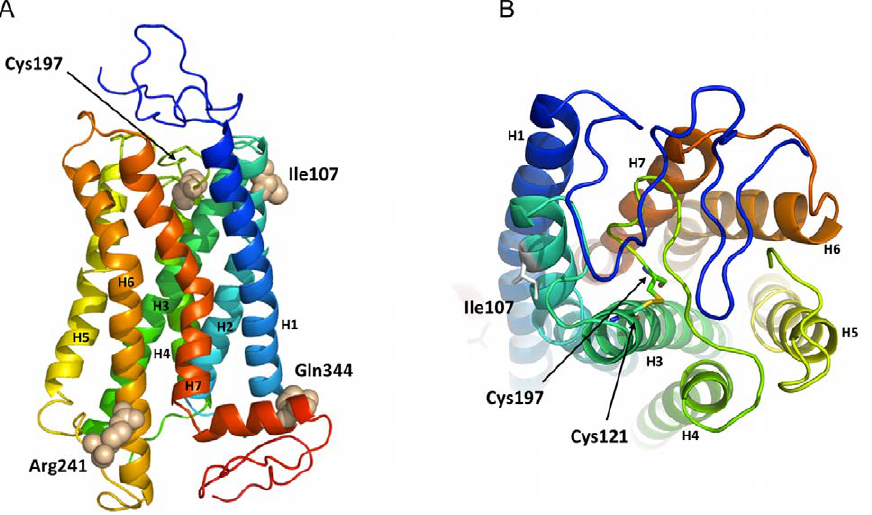
Figure 5. Molecular model of NPSR1. A) The molecular model of NSPR1 indicates that residues Ile107, Cys197 and Agr 241 are localized at each end of the transmembrane NSPR1 protein, while residue Cys197 is within the presumptive NPS-binding site. The model (side view) is oriented with the extracellular matrix and the cytosolic compartment at the top and at the bottom, respectively. Each of the seven helices that compose the NPSR1 transmembrane core is indicated with a different color and annotated with H. The side chains of the four different residues are displayed as spheres. B) View of the molecular model of NPSR1 seen from the extracyoplasmic domain. Residues Ile107, Cys197 and Cys121 are indicated as sticks. The side chains of Cys197 and Cys121 form a disulfide bridge within the NPS-binding